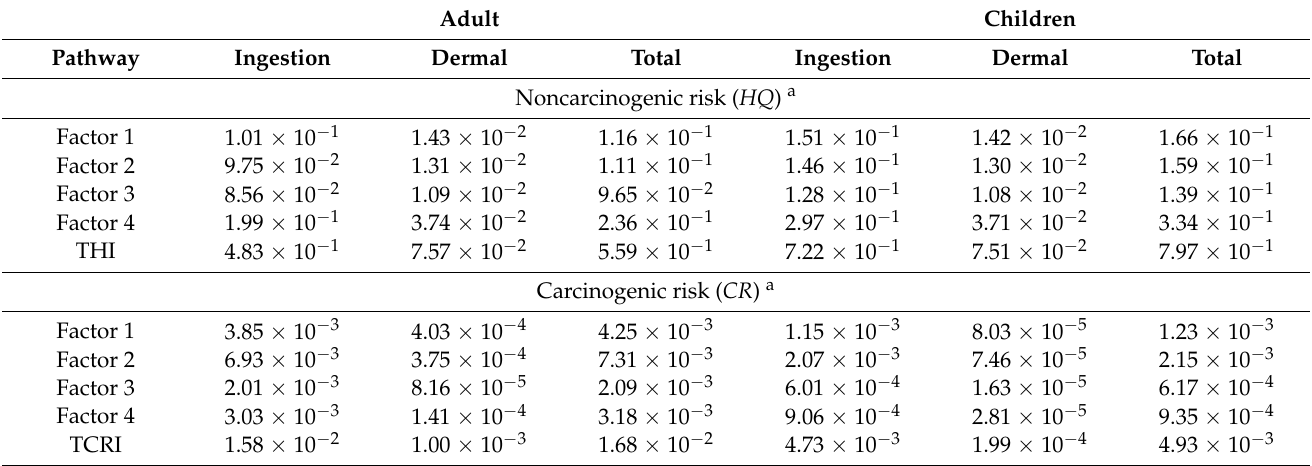
Table 6. HQ , HI , THI , CR , and TCRI for adults and children calculated by PMF mode.